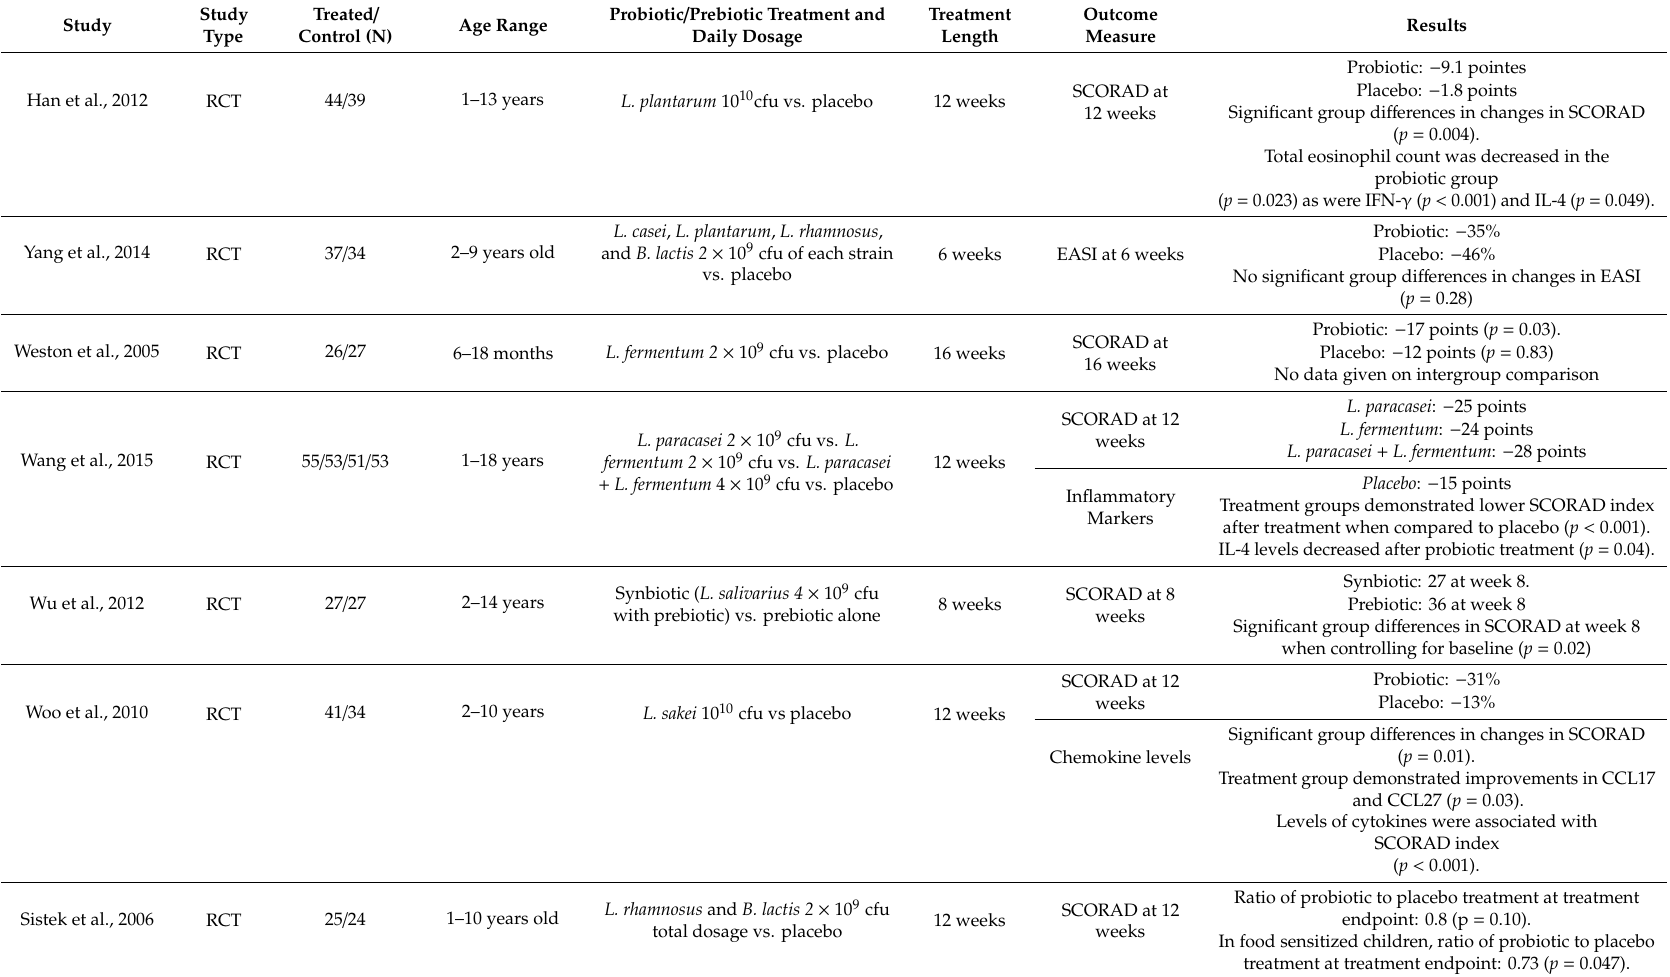
Probiotic: − 9.1 pointes Placebo: − 1.8 points Significant group di ff erences in changes in SCORAD ( p =